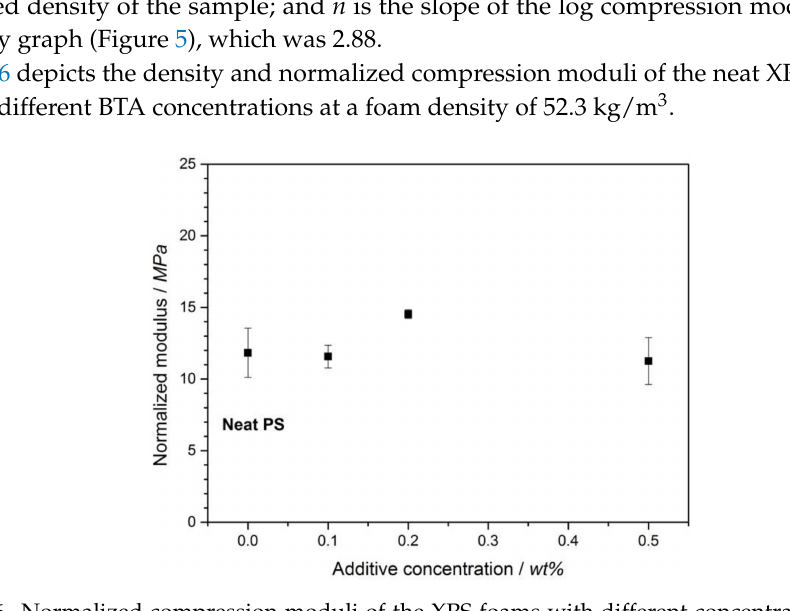
Figure 6. Normalized compression moduli of the XPS foams with different concentrations of BTA compared to the neat XPS